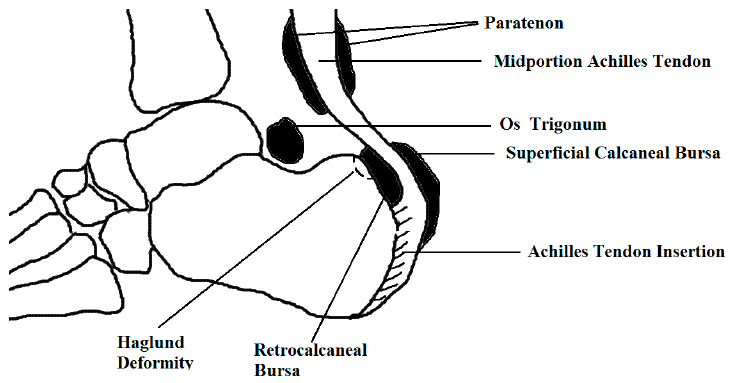
Figure 1. Hindfoot and posterior ankle anatomy.